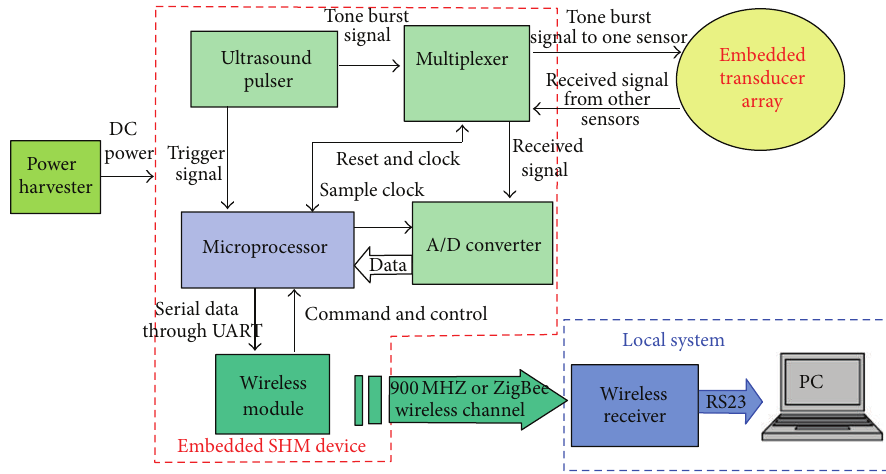
Figure 35: Diagram of the embedded ultrasonic structural health monitoring system [28].